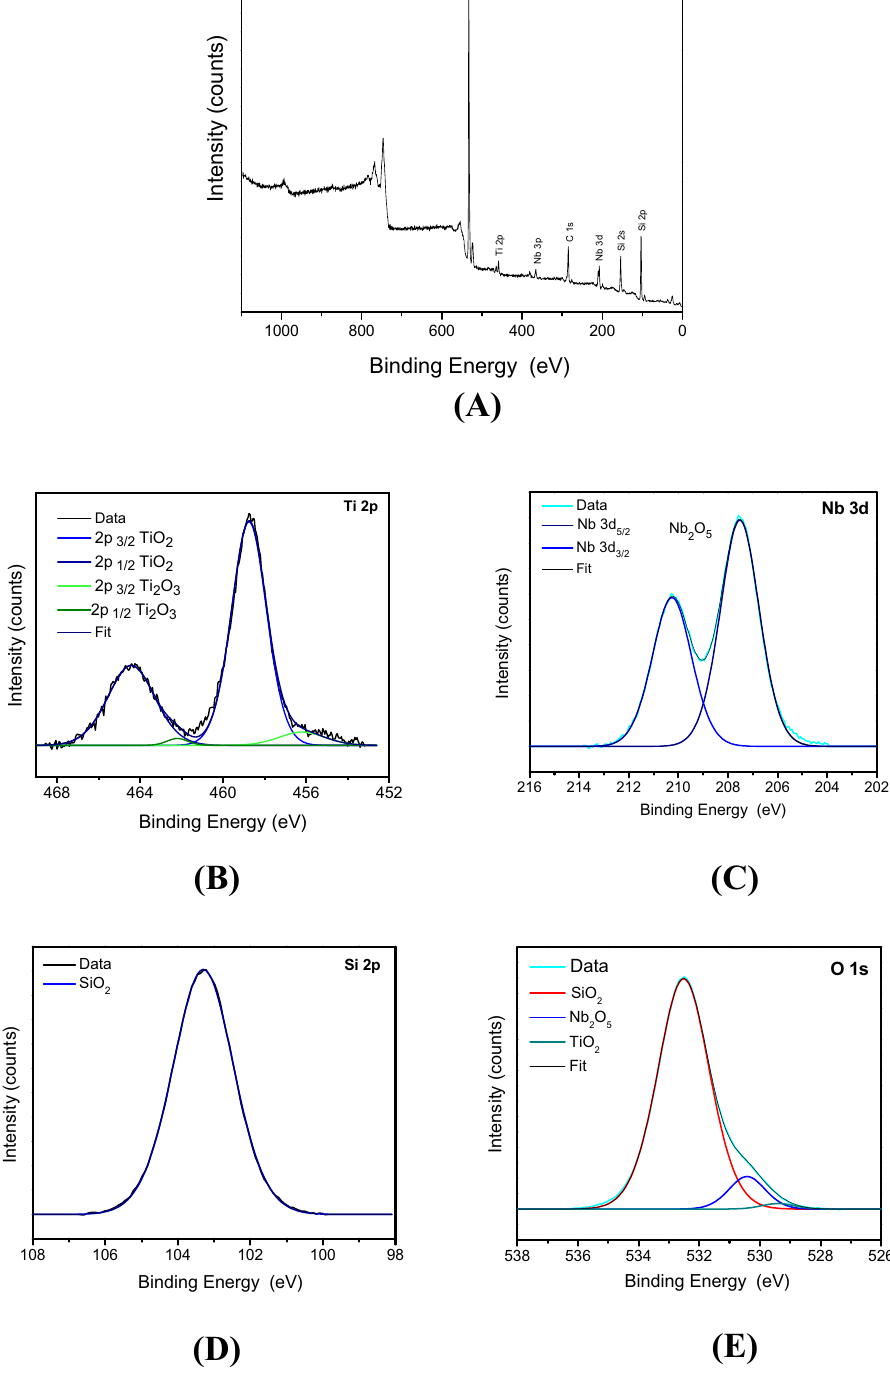
Figure 6. XPS analysis of SiTiNb-A material. Survey Spectrum (A) and the higher resolution spectra in the regions of Ti 2p (B) , Nb 3d (C) , Si 2p (D) e O 1 s (E)